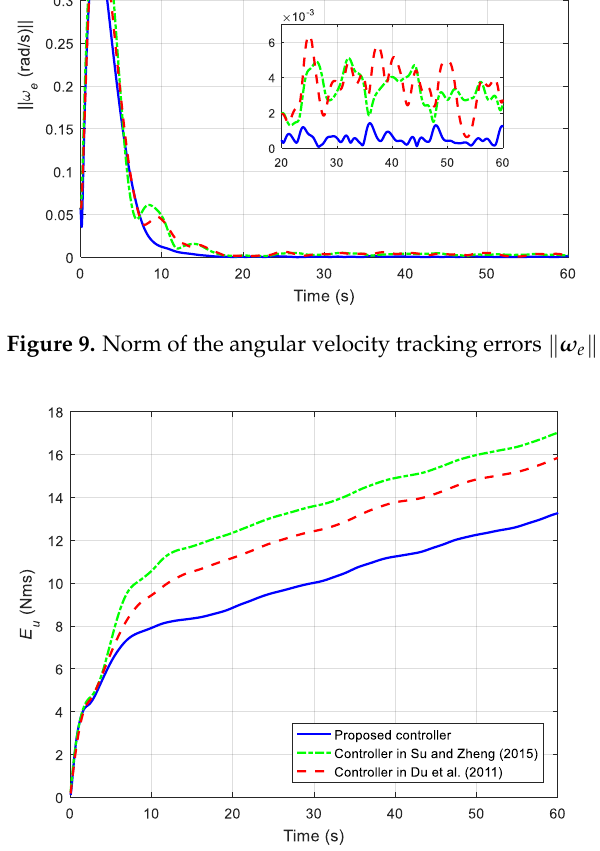
Figure 10. Profile of the energy consumption index